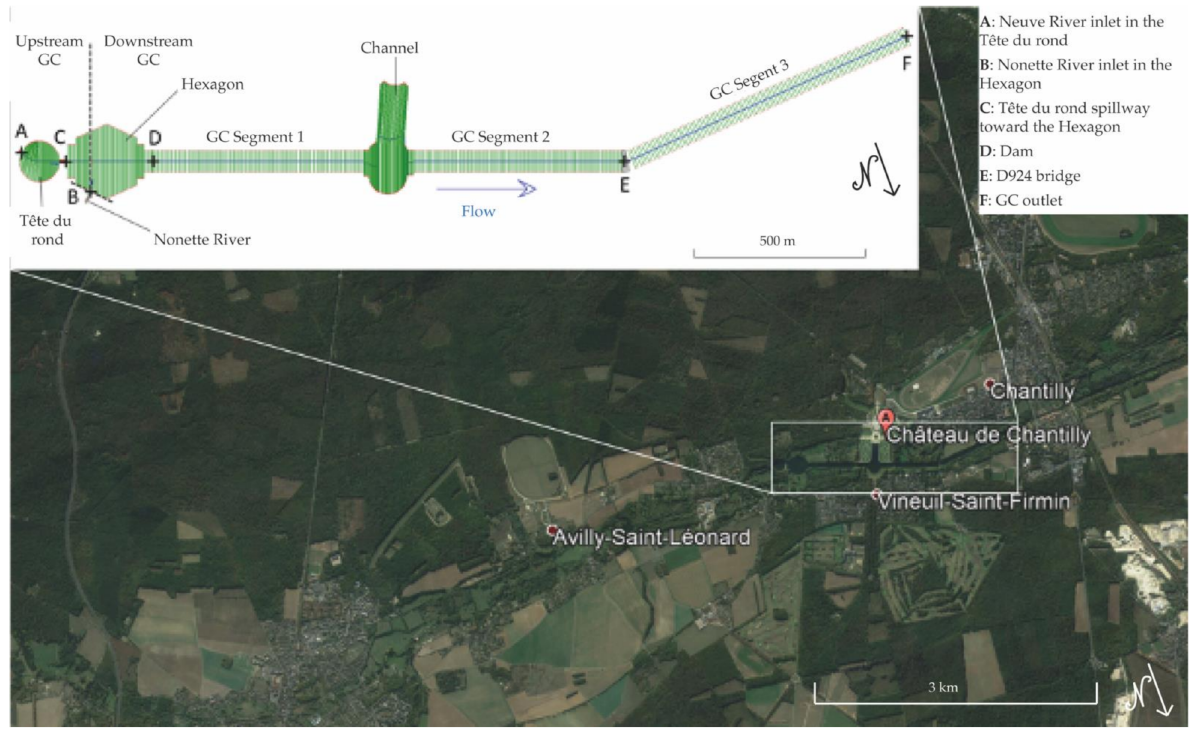
Figure 7. Situation of Chantilly domain (Google Earth); bird’s-eye view from the GC; geometry represented in HEC-RAS and hydraulic peculiarities along the